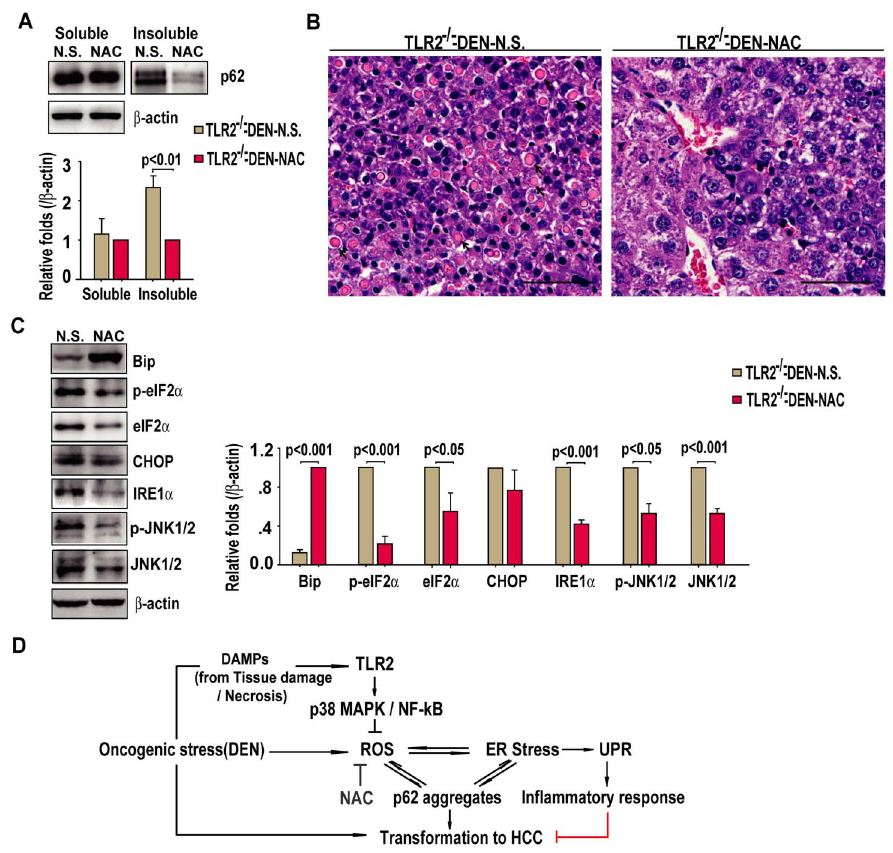
Figure 5. Antioxidant NAC ameliorates TLR2 2 / 2 - exacerbated ER stress in HCC tumors. (A) Western blot detection of p62 in the detergent- soluble and insoluble fractions of liver tissues of DEN-induced TLR2 2 / 2 mice treated and untreated with NAC. Data are mean 6 SEM (n=4 per group, bottom panel). (B) Representative images of H&E stained liver showing Mallory-Denk bodies (arrow, n=4 livers per group). Scale bar, 50 m m. (C) Western blot detection of Bip, phospho-eIF2 a , eIF2 a , CHOP, IRE1 a , phospho-JNK1/2 and JNK1/2 in livers tissues of DEN-induced TLR2 2 / 2 mice treated and untreated with NAC. Data are mean 6 SEM (n=4 per group, right panel). (D) A schematic diagram showing how TLR2 may protects against DEN-induced hepatocarcinogenesis. Upon exposure to oncogenic stressors, such as DEN, TLR2-mediated signaling prevents ROS accumulation and ER stress, thereby preventing p62 aggregation and discouraging transformation. Inhibition of TLR2 signaling in liver under the conditions of oncogenic stressors could lead to uncontrolled ROS accumulation and ER stress, promoting tumorigenesis of liver cells.